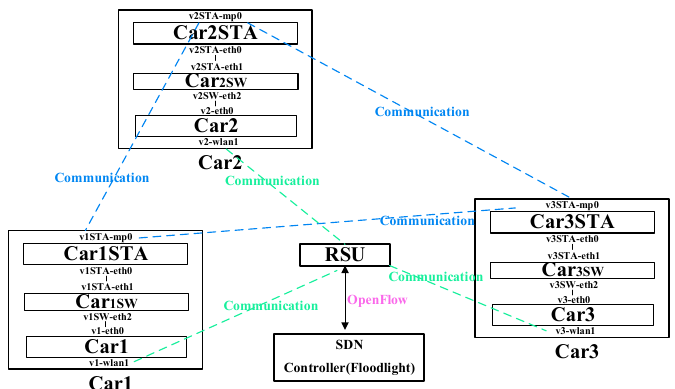
Figure 5. The communication architecture for SD-VEC. Table 2. Description of the simulation experimental parameters.